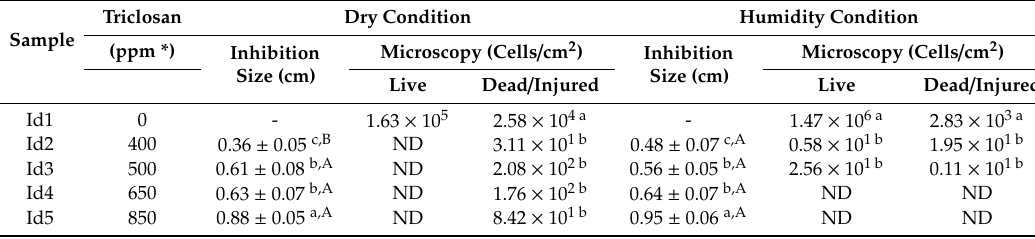
Table 2. Bacterial inhibition (size of the inhibition is expressed in cm) of S. aureus on surfaces treated with triclosan (400 to 850 ppm) or not treated (0 ppm) after 24 h incubation. The presence of live and dead or injured cells by epifluorescence microscopy are expressed in cells / cm 2 .